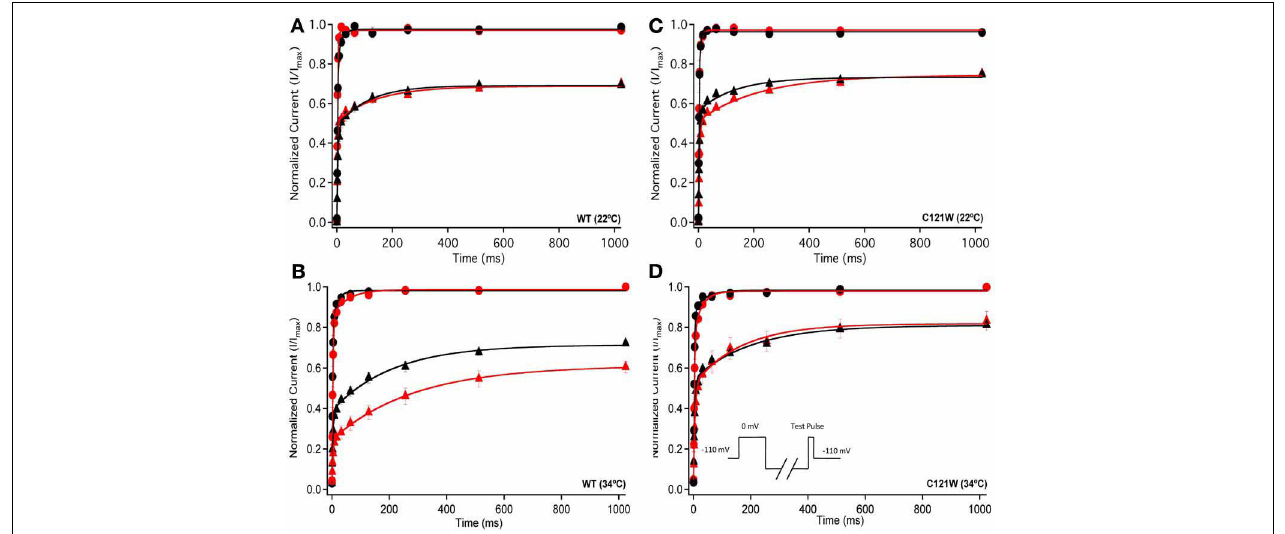
FIGURE 3 | Fast inactivation recovery. Normalized Current is plotted against a range of recovery durations (ms). Filled circles shows fast inactivation recovery elicited by 20ms prepulse durations; whereas closed triangles represent prepulse durations of 500ms. For both WT at 22 ◦ C and